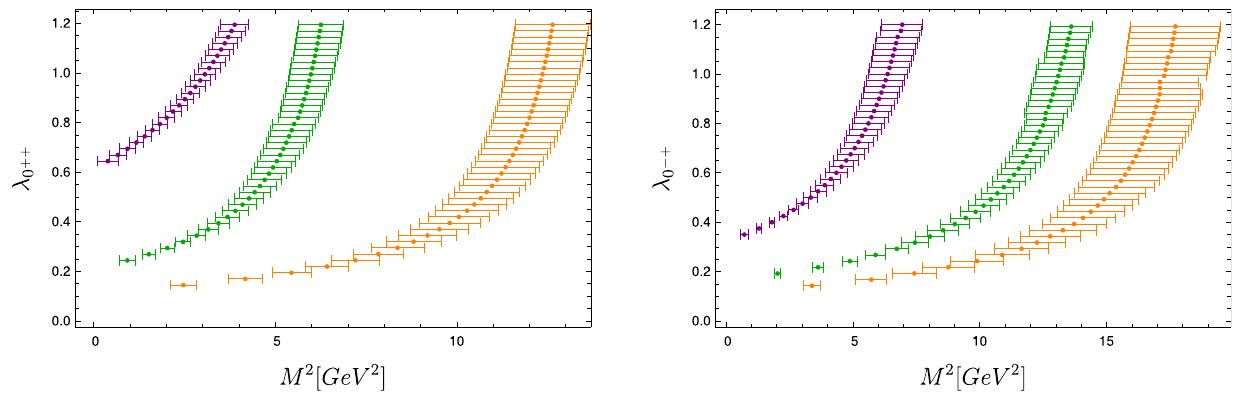
Fig. 6 Eigenvalues for off-shell values of P 2 = − M 2 for scalar (left) and pseudoscalar (right) glueballs. Shown are the eigenvalues for the ground state and the first two excited states Table 1 Ground and excited state masses M of scalar and pseudoscalar glueballs.Comparedarelatticeresultsfrom[4–6]withtheresultsofthis work. For [4,5], the errors are the combined errors from statistics and the use of an anisotropic lattices. For [6], the error is statistical only. In